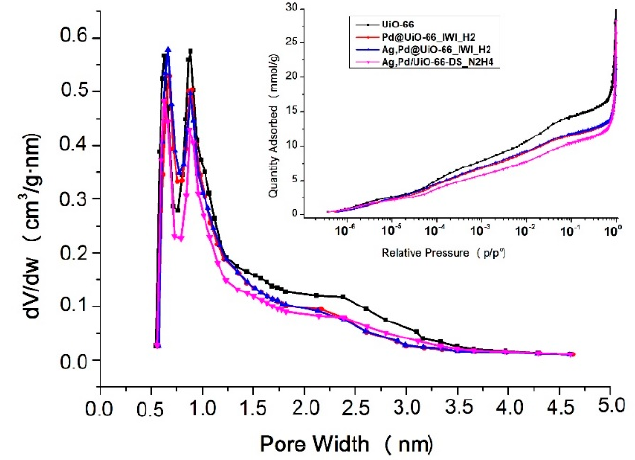
Figure 4. Pore size distribution and low-temperature N 2 adsorption isotherms of UiO-66 (black), Pd@UiO-66_IWI_H 2 (red) and AgPd@UiO-66 samples prepared by IWI_H 2 (blue) and DS_N 2 H 4 (magenta).